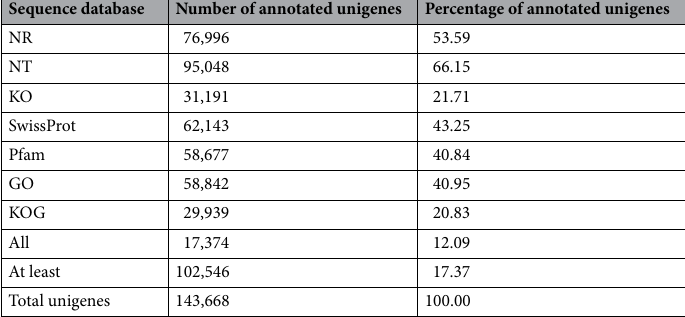
Table 2. Summary of the annotation information of unigenes related to oil palm fruit exocarp color in public databases.